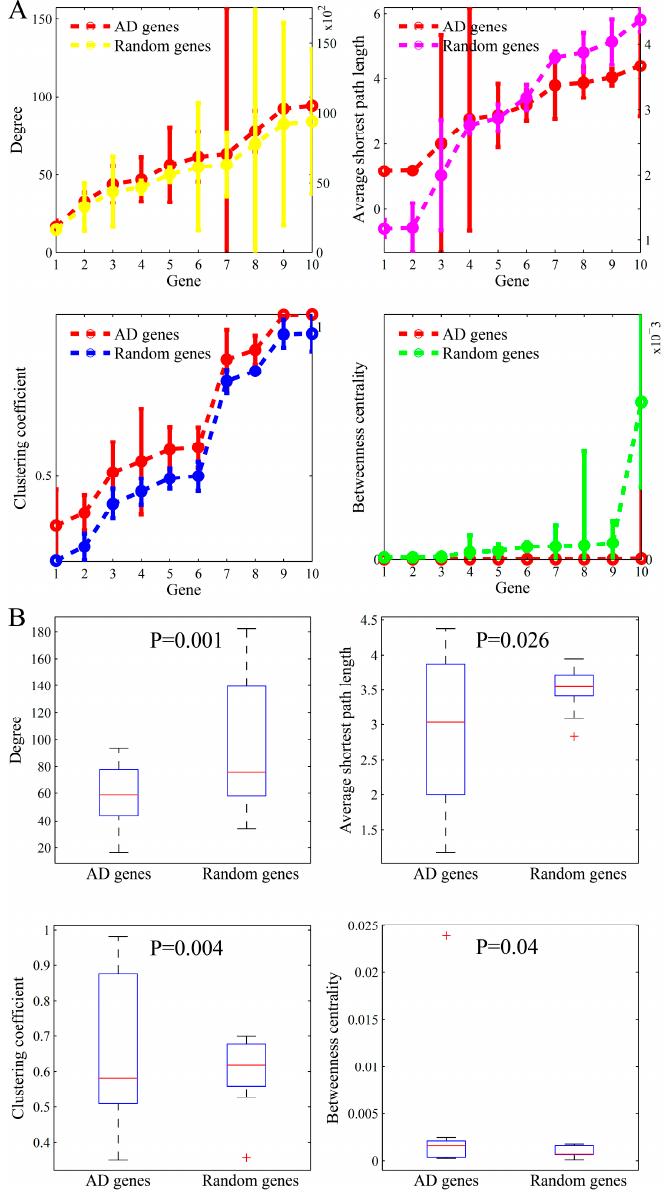
Figure 6. The comparison of topological parameters between AD (Alzheimer’s disease) genes and randomly-selected genes. ( A ) The means (left y-axis) and standard deviations (right y-axis) of the four parameters in the ten AD gene groups and those corresponding in the randomly-selected ten gene groups. ( B ) Boxplots of these parameters.